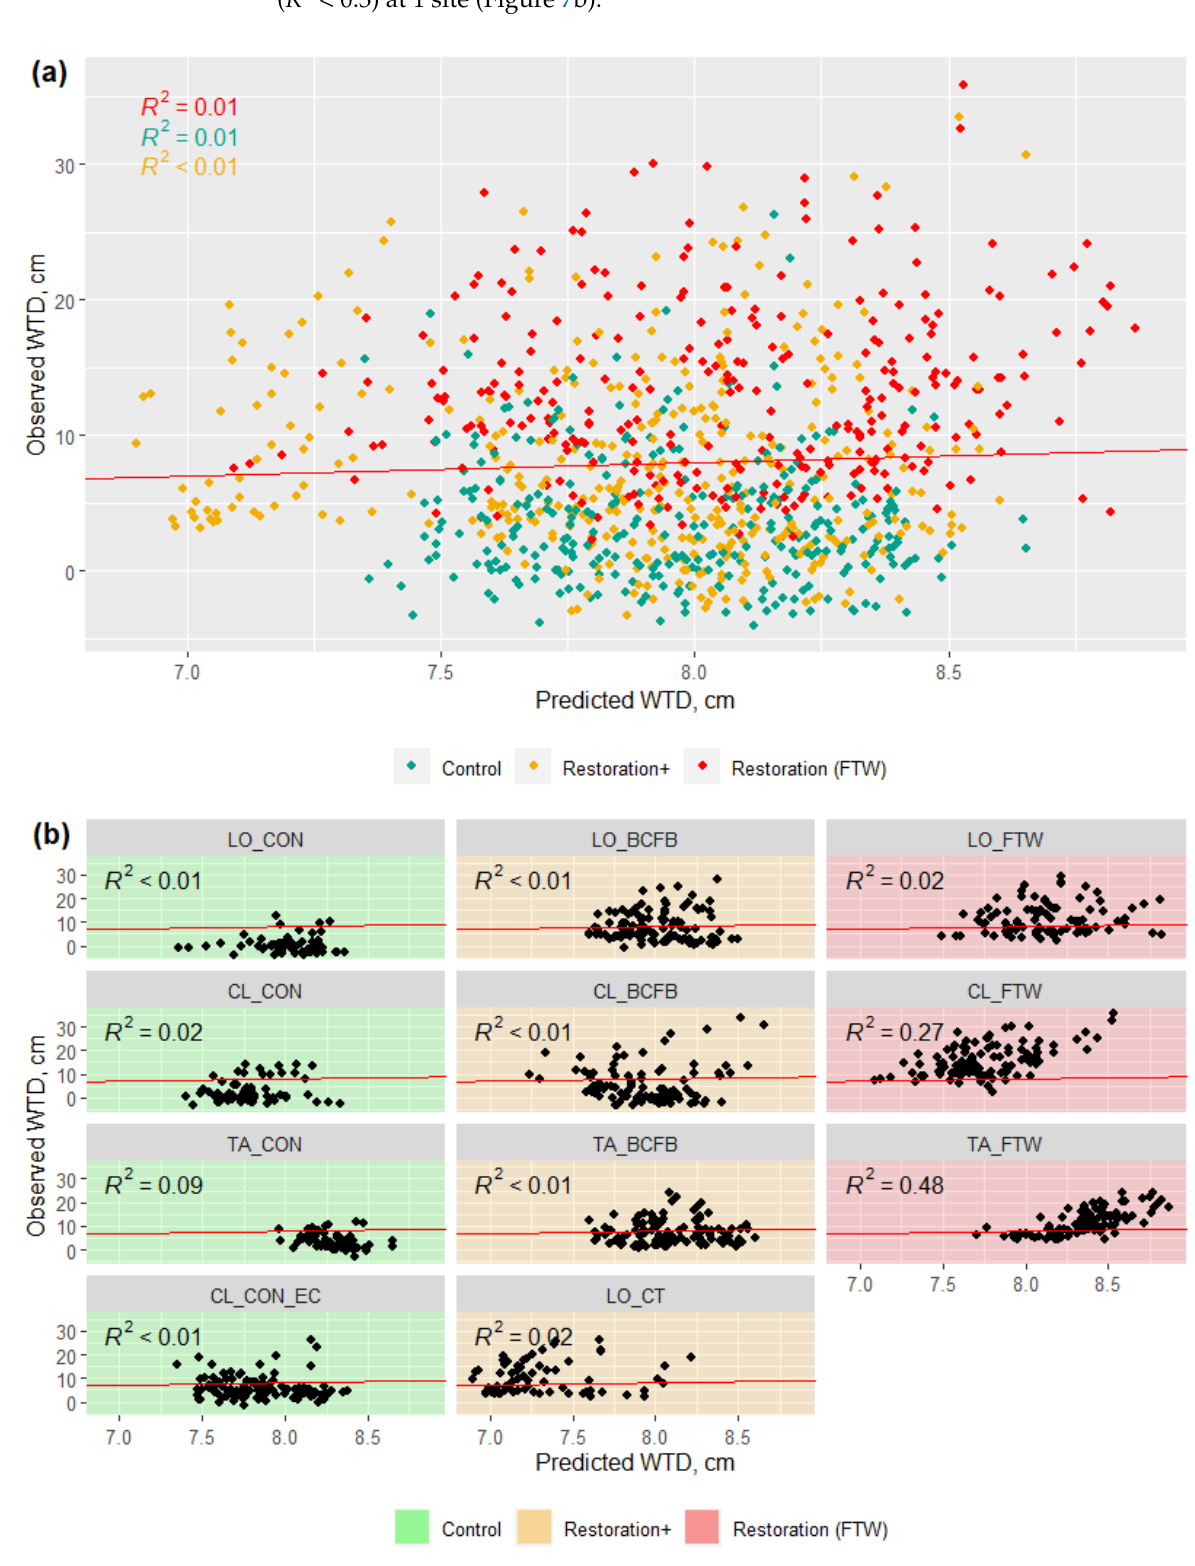
Figure 6. SLR model output for Forsinard Flows sites (predicted vs. observed WTD) for ( a ) all data points; ( b ) splitting data into the individual sites. The red line represents a perfect agreement between the prediction and the field measurement.